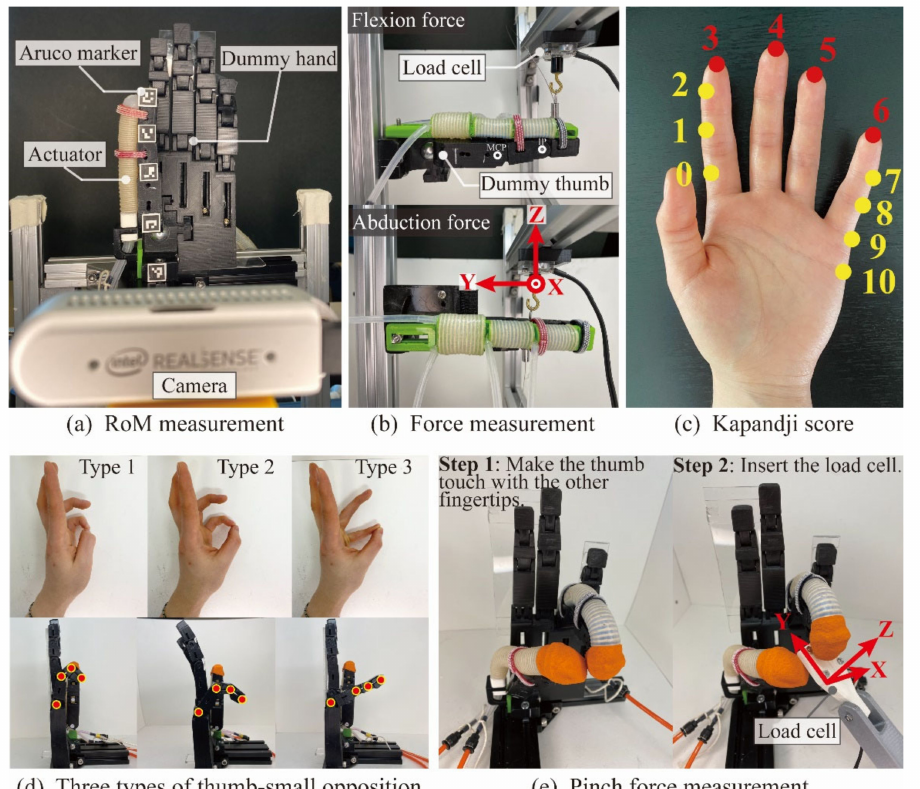
Figure 2. Measurement